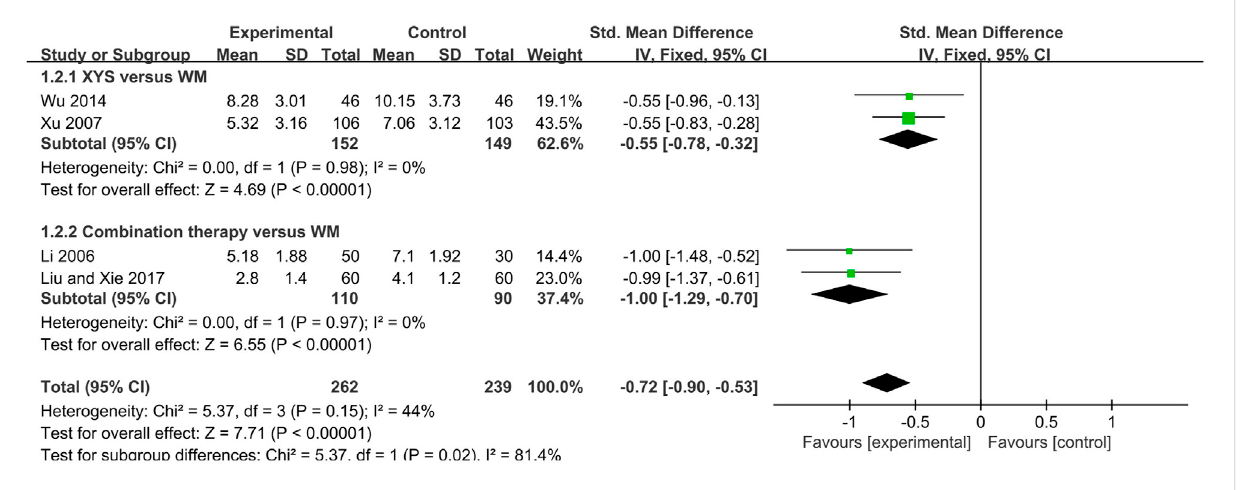
FIGURE 5 Forest plot of the comparison for dyspepsia-related symptom score between the XYS and WM groups.